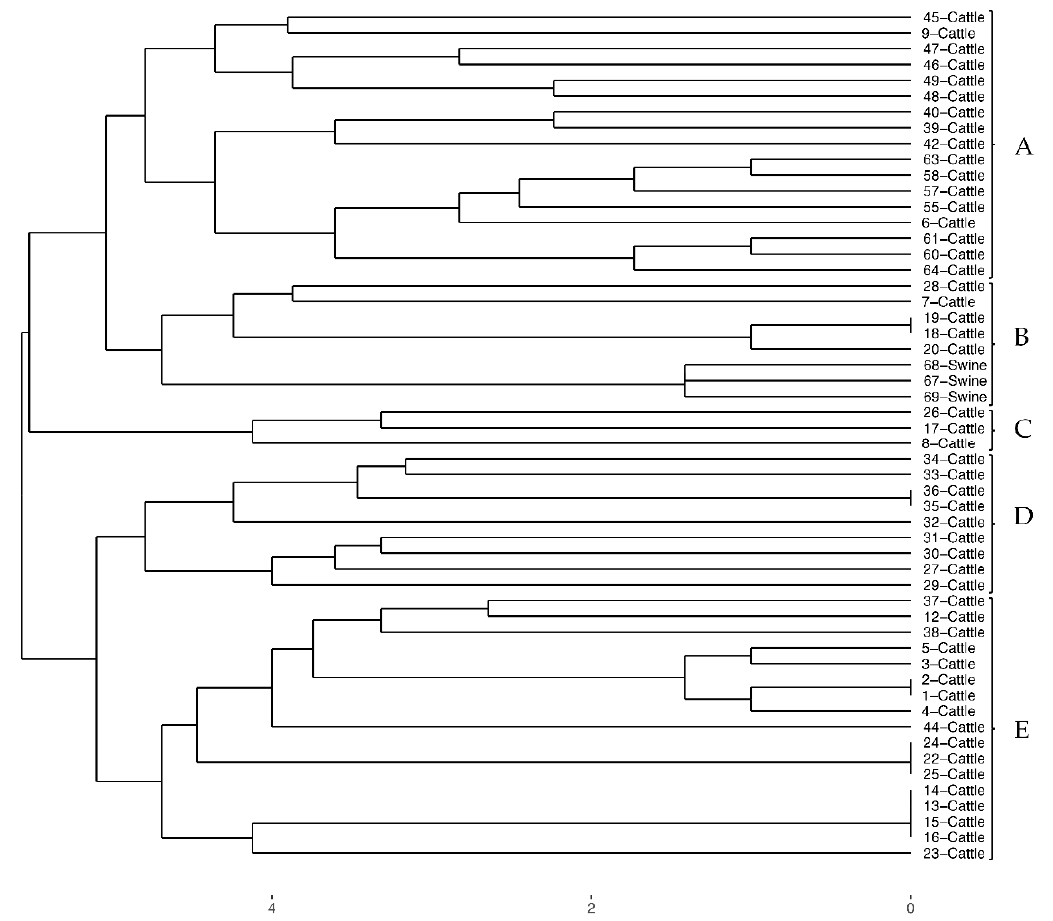
Figure 2. Dendrogram resulting from combined PFGE and PCR data obtained from all 54 STEC strains isolated, showing five clusters (A to E).